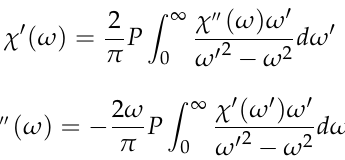
Figure 3. The wavelength dependence of the phase shift of the reflected and transmitted electric fields calculated using a field transfer matrix formula Equations (1) and (2), respectively.